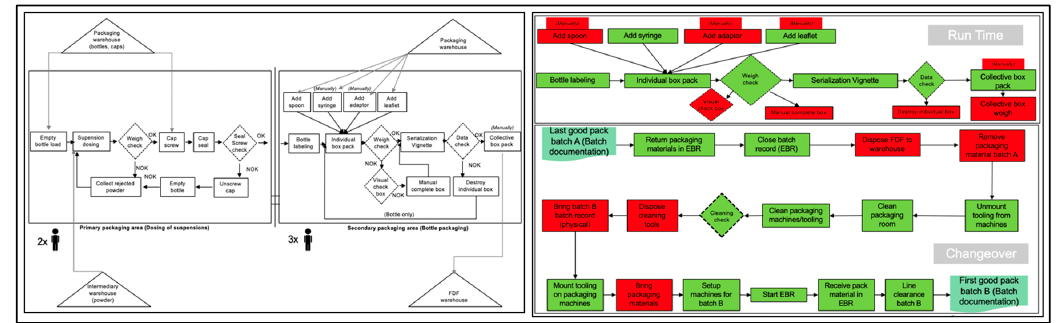
Figure 1. Process mapping ( left ) and Value-added activities ( right ). Legend: OK (OK, Good process step); NOK (Not OK, Failed process step); FDF (Finished Dosage Form); EBR (Electronic Batch Record).